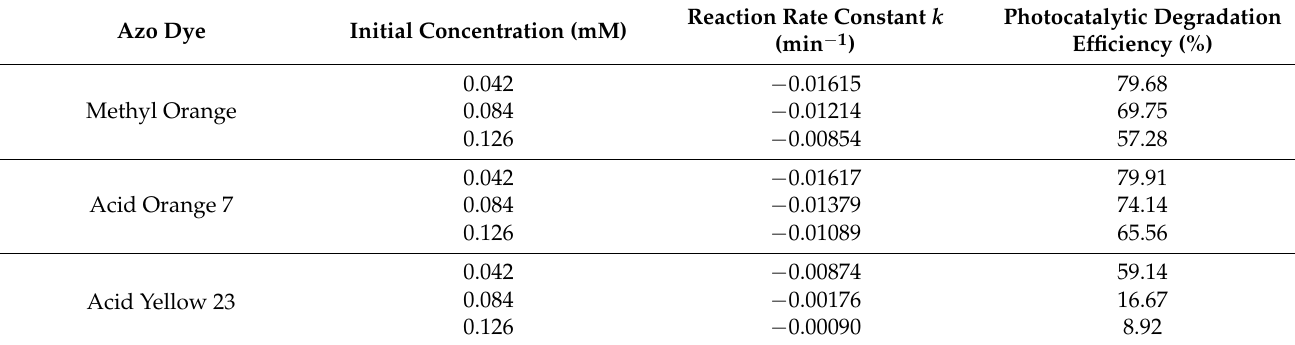
Table 2. Reaction rate constant ( k ) and photocatalytic degradation efficiencies (%) of Gd 2 O 3 nanoparticles for the degradation of the azo dyes MO, AO7, AY23 in the presence of H 2 O 2 at different initial dye concentrations. Reaction Rate Constant k Photocatalytic Degradation Azo Dye Initial Concentration (mM) (min − 1 ) Efficiency (%) 0.042 − 0.01615 79.68 Methyl Orange 0.084 − 0.01214 69.75 0.126 57.28 0.042 Acid Orange 7 65.56 0.042 59.14 0.084 − 0.00176 16.67 Acid Yellow 23 0.126 − 0.00090